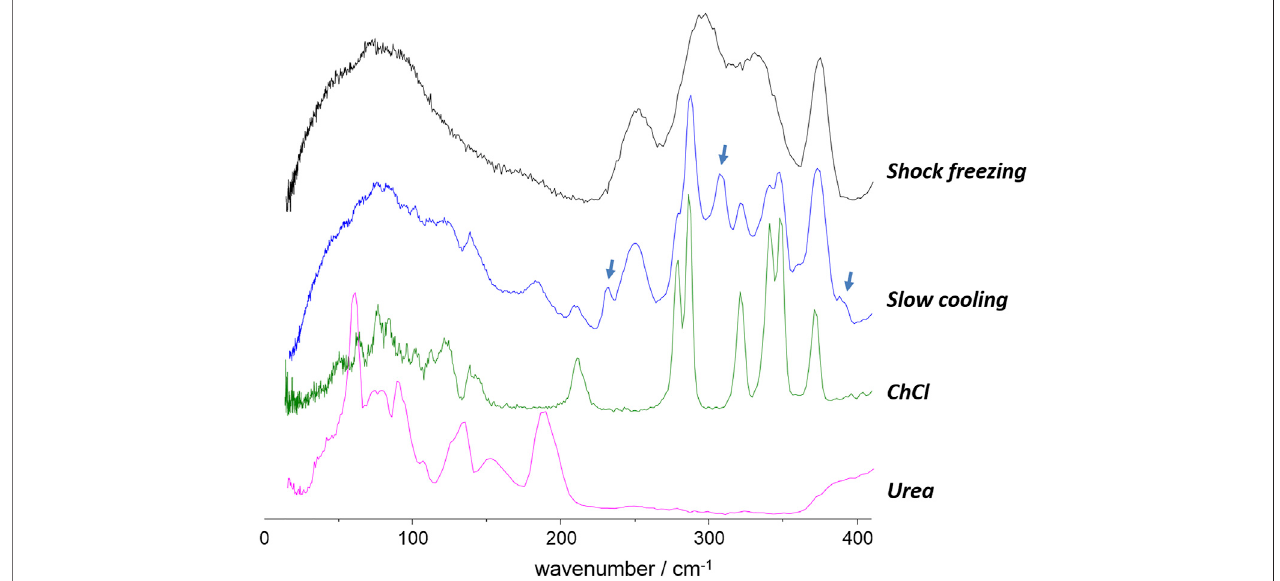
FIGURE3| INS spectra ofChCl:urea eutectic mixture withincreasingwater content,in the0 – 1,000 cm − 1 range. From bottom totop: DES:water molar ratioof1:0 ( ca . 0.8%water wt, 0w), 1:1 (ca. 6.5% wt, 1w), 1:3 (ca. 17.0% wt, 3w), and 1:5 (ca. 26.0% wt, 5w).